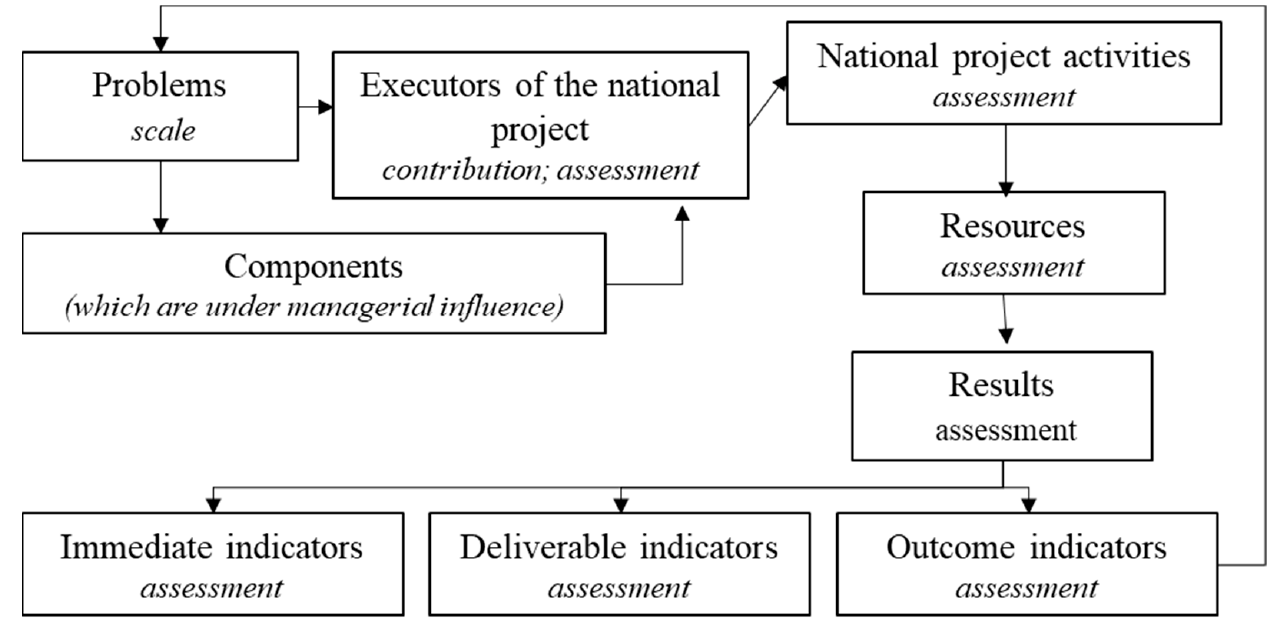
Figure 2. Map of the results of the project.